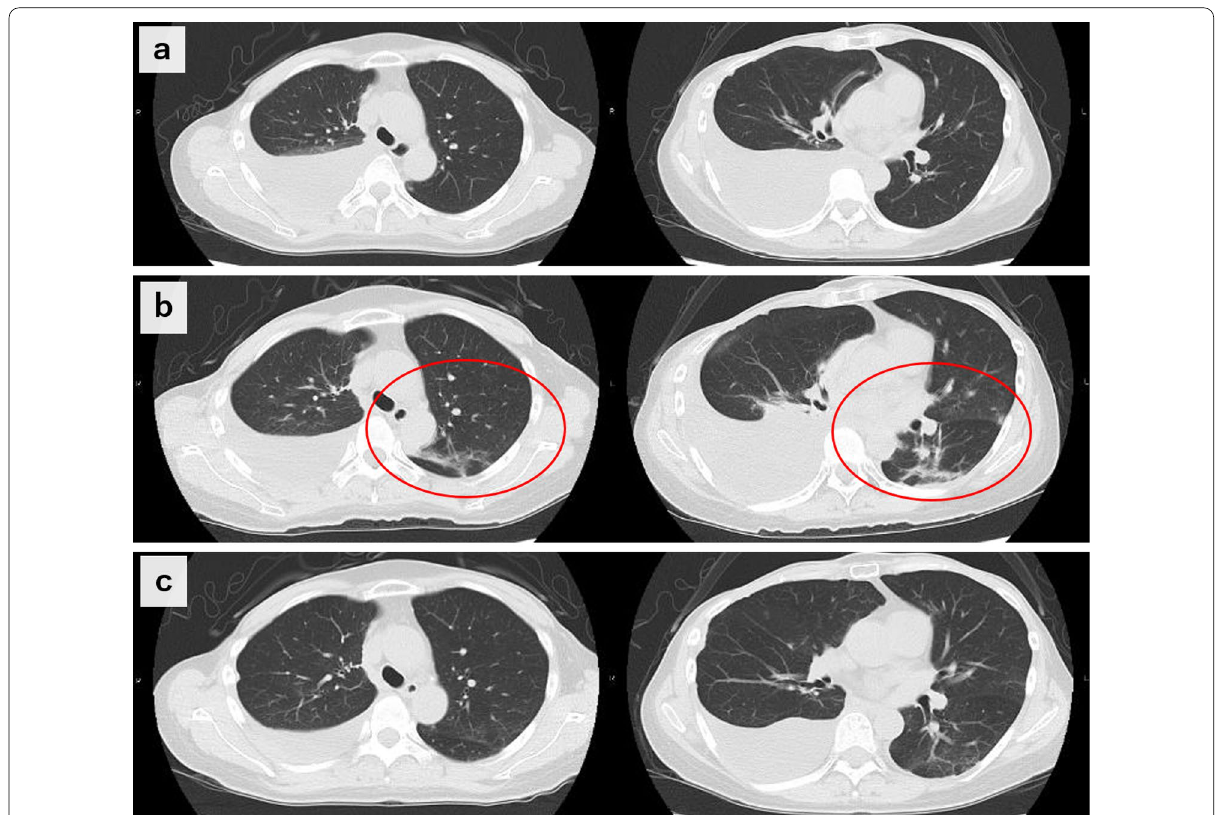
Fig. 3 CT scan findings over the clinical course. a Day of hospitalization; b 7 days after hospitalization; c 2 weeks after hospital discharge. Red circles indicate pneumonia